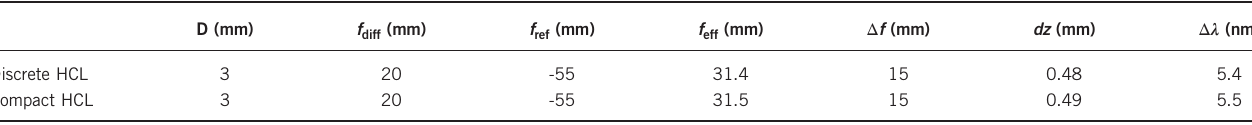
Table 2 Comparison of the effective focal length, longitudinal chromatic aberration, axial resolution, and spectral resolution of the discrete and compact HCL structures